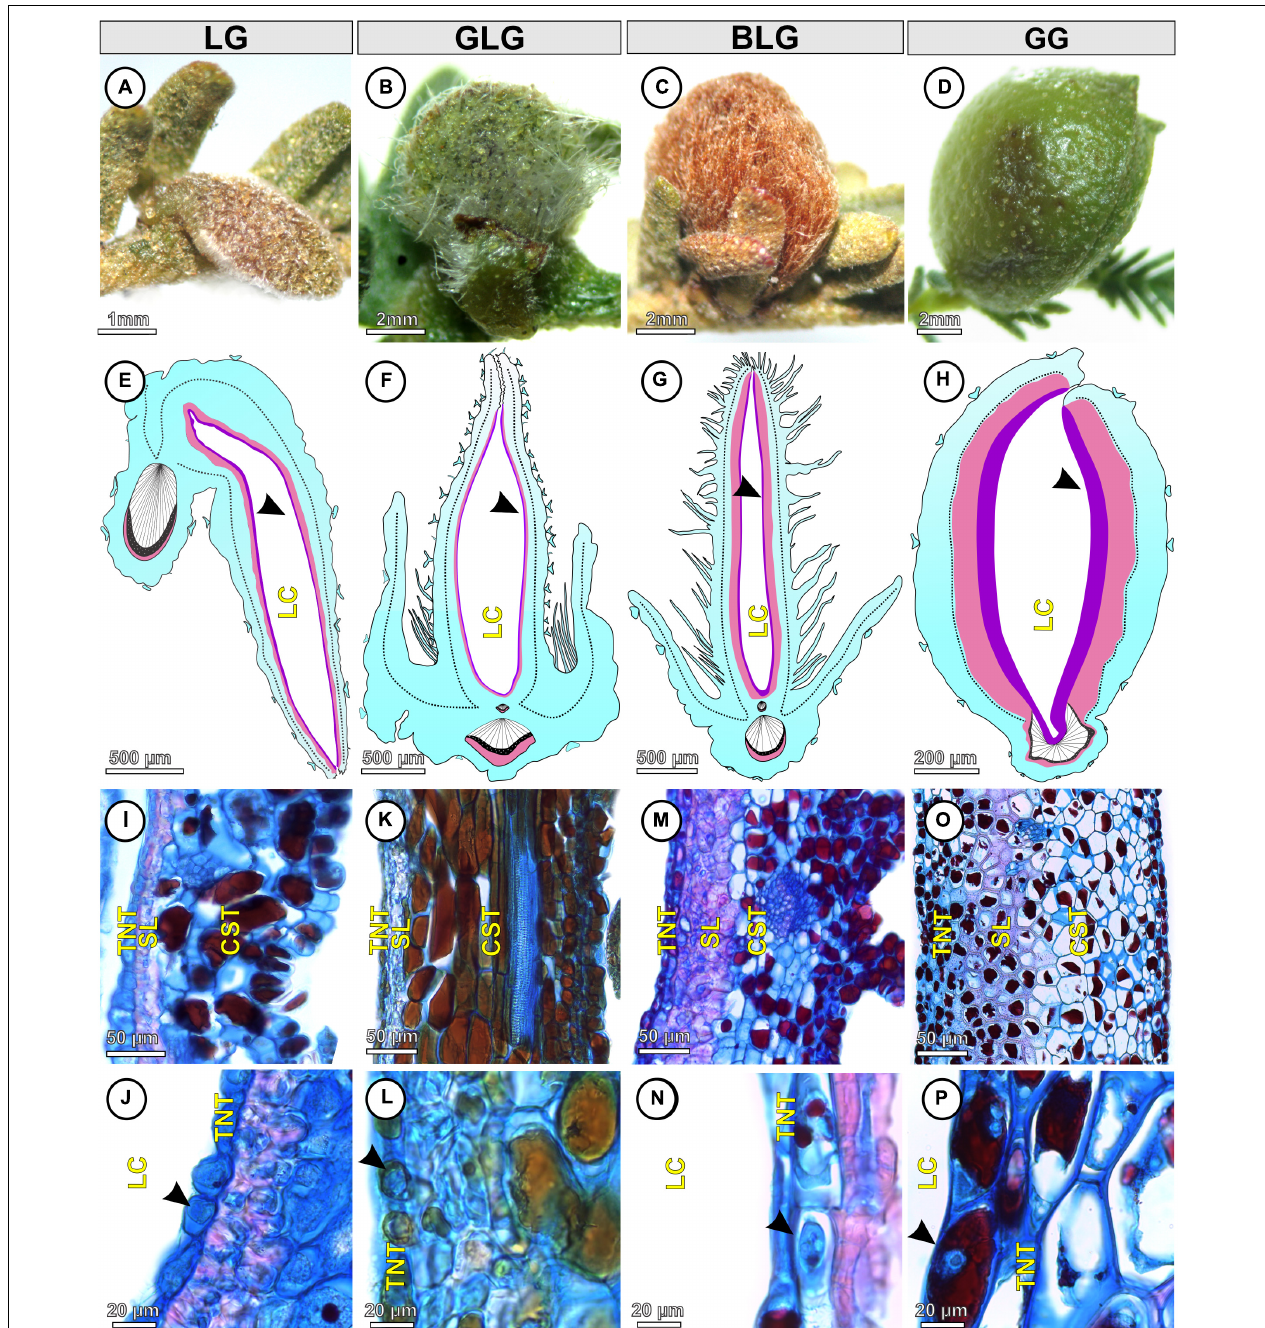
FIGURE 2 | Structural profiles of the four Lopesia galls on Mimosa gemmulata Barneby (Fabaceae) pinna-rachis in transverse sections. (A–D) Macroscopic aspect of the galls. (A,E) Lenticular bivalve-shaped gall. (B,F) Green lanceolate bivalve-shaped gall. (C,G) Brown lanceolate bivalve-shaped gall. (D,H) Globoid bivalve-shaped gall. (E–H) Diagram of the Lopesia galls, evidencing common storage tissues (blue), schlerenchymatic layers (pink) in the outer tissue compartments, and typical nutritive tissues (purple–black arrowheads) in the inner tissue compartments. (I,J) Lenticular bivalve-shaped gall, evidencing common storage tissue, schlerenchymatic layer and typical nutritive cells with evident nuclei (black arrowhead). (K,L) Green lanceolate bivalve-shaped gall, evidencing common storage tissue, schlerenchymatic layer and typical nutritive cells with evident nuclei (black arrowhead). (M,N) Brown lanceolate bivalve-shaped gall, evidencing common storage tissue, schlerenchymatic layer and typical nutritive cells with evident nuclei (black arrowhead). (O,P) Globoid bivalve-shaped gall, evidencing common storage tissue, schlerenchymatic layer and typical nutritive cells with evident nuclei (black arrowhead). BLG, brown lanceolate bivalve-shaped gall; CST, common storage tissue; GG, globoid bivalve-shaped gall; GLG, green lanceolate bivalve-shaped gall; LC, larval chamber; LG, lenticular bivalve-shaped gall; SL, schlerenchymatic layer; TNT typical nutritive tissue.